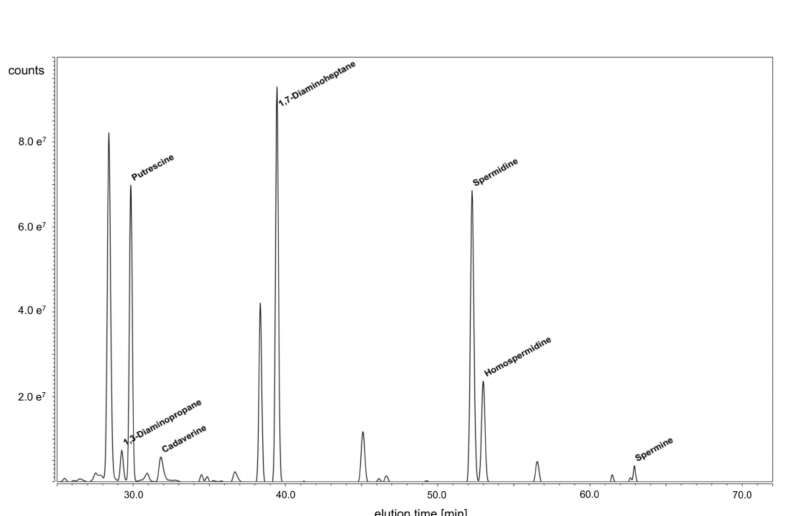
Figure A1. HPLC chromatogram of polyamines of the hairy root control line HR-CT1. All labeled peaks were identified by running pure standards under the same experimental